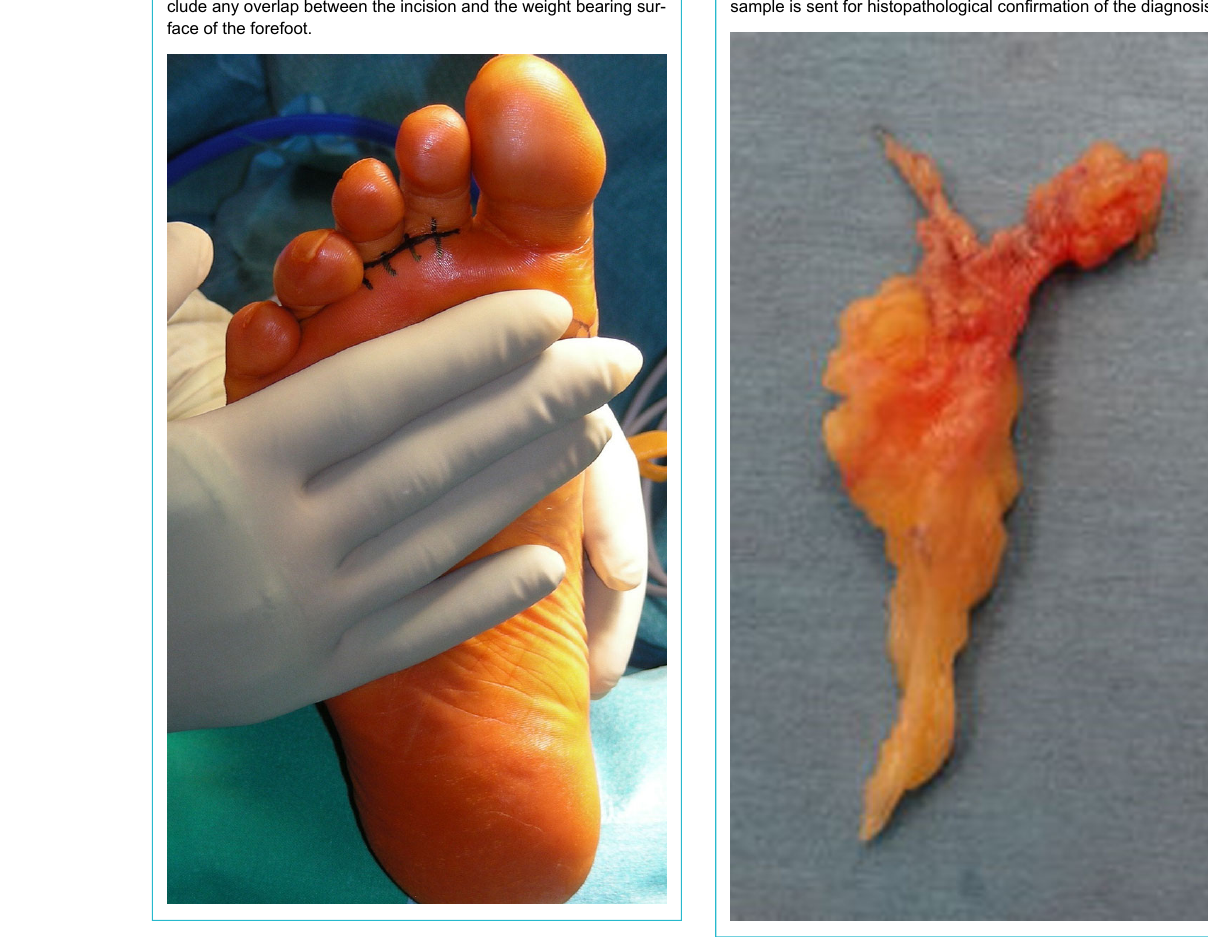
Figure 3: After exposure of the subcutaneous tissues, the neuro- ma is identified, here in the second web space.